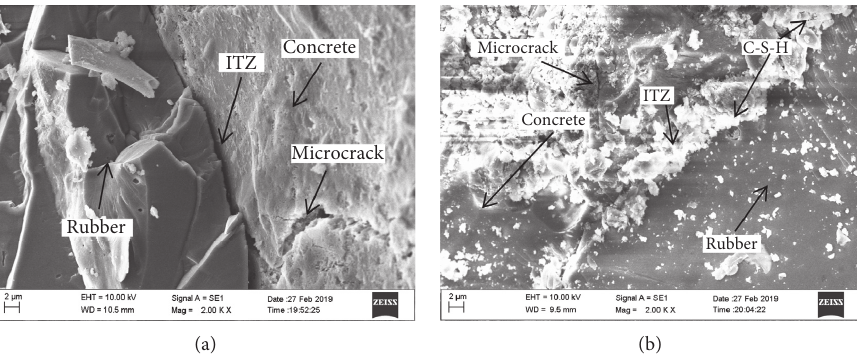
Figure 7: Representative SEM images of SFNS-CRC: (a) v